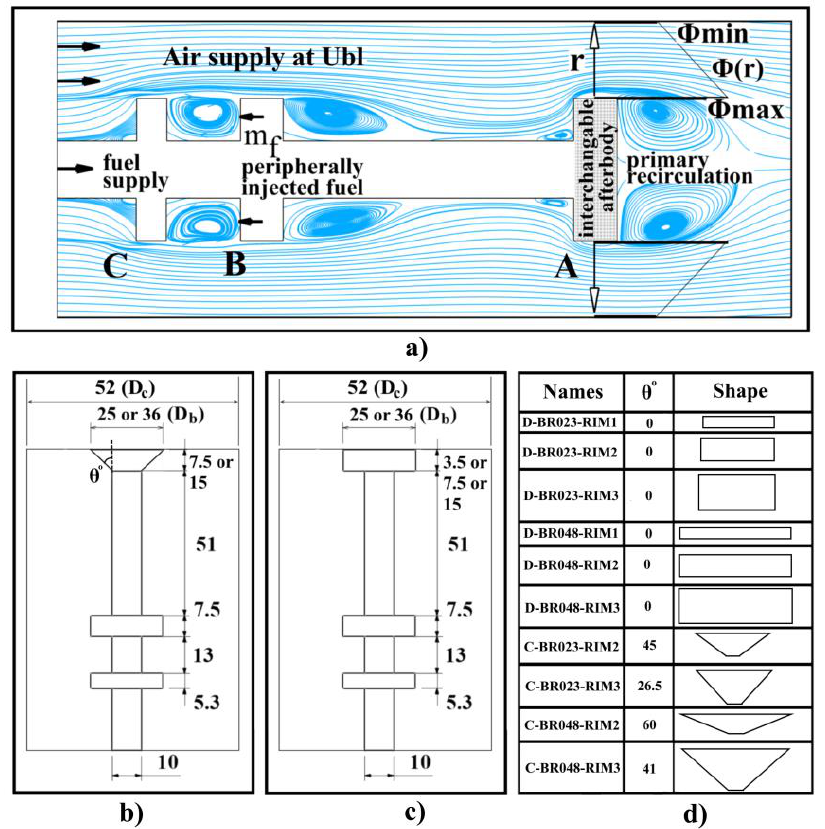
Figure 1. Premixer/burner configurations, ( a ) flow patterns of premixer/burner set up, ( b ) cone shaped after – body premixer/burner set up, ( c ) disk shaped after – body premixer/burner set up, ( d ) investigated after – bodies.